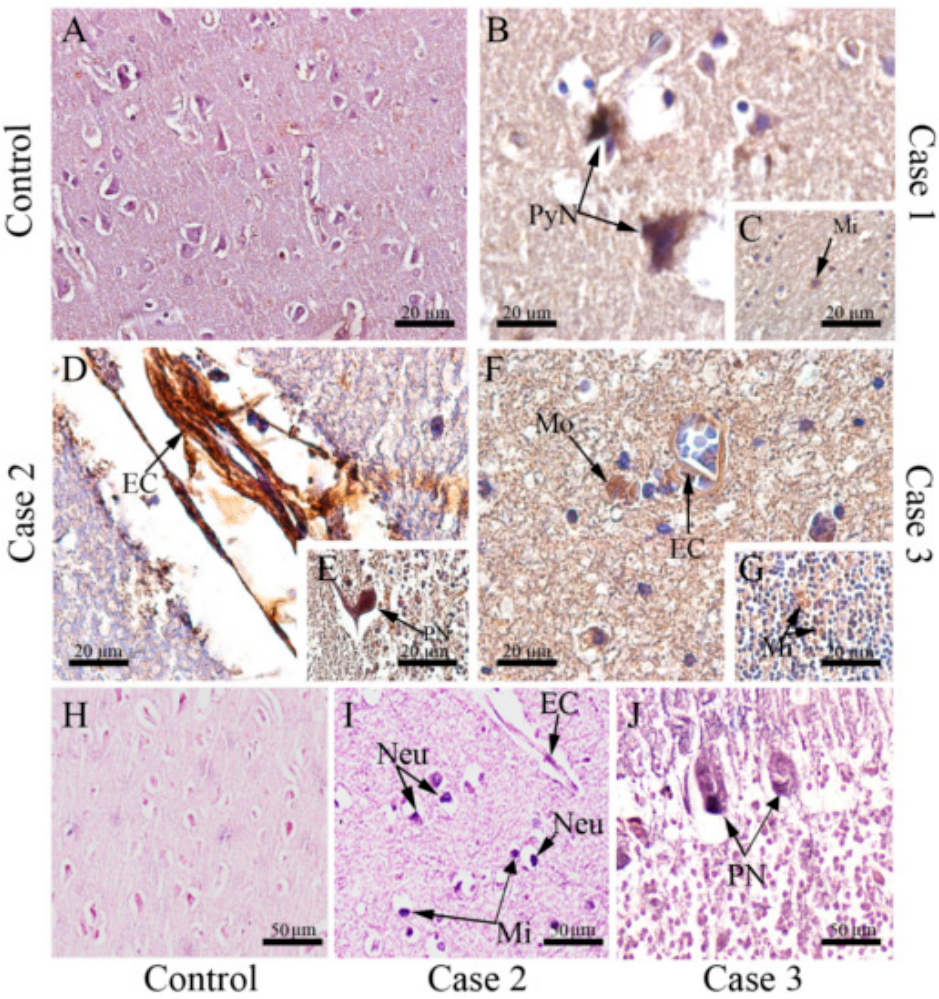
Figure 4. Detection of NS3 protein in the brain tissue of fatal cases. ( A ) Immunoperoxidase technique. Brain of a non-dengue case without NS3 detection; ( B ) Detection of DENV-NS3 protein in pyramidal. neurons and ( C ) microglia of the white matter in case 1; ( D ) in endothelial cells and ( E ) Purkinje neuron in case 2; ( F ) in endothelial cells and macrophages ( G ) and microglia in granular layer of case 3; ( H ) Hybridization in situ technique—brain of a non-dengue case; ( I ) Detection of DENV RNA negative strand in neurons, endothelial cells, microglial cells in case 2 ( J ) and Purkinje neurons in case 3. Neu—Neuron, Mi—Microglia, EC—Endothelial cells, Mo—Macrophages, PyN—Pyramidal neurons, PN—Purkinje neuron.